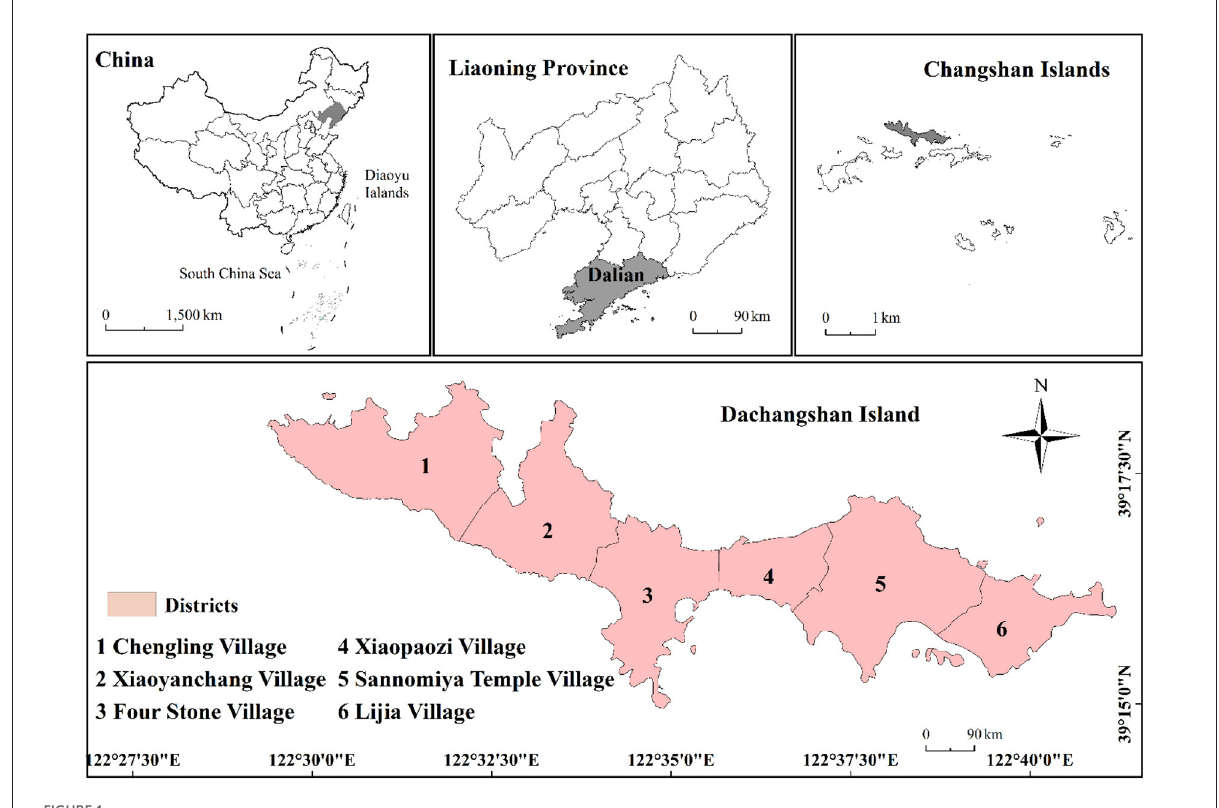
FIGURE1 Location of the study area.